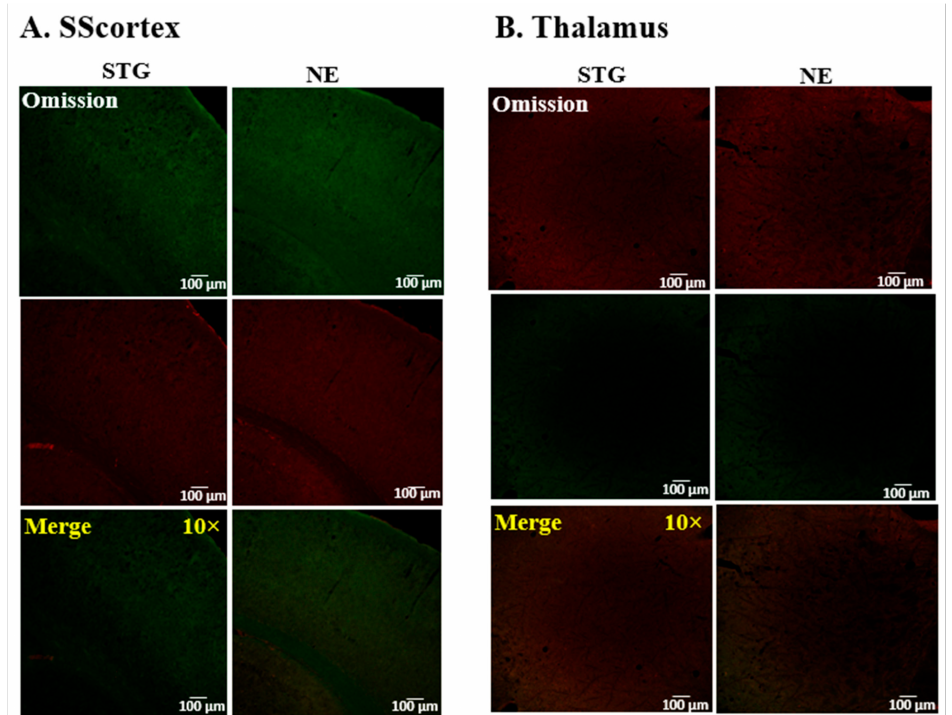
Figure 5. Representative confocal images showing the specificity of secondary antibody binding after the omission of primary antibodies in tissue sections from the ( A ) SScortex and ( B ) thalamus of epileptic stargazers (STG) and non-epileptic littermates (NE). Merged images at low magnification (10 × ) are shown in the bottom panel.